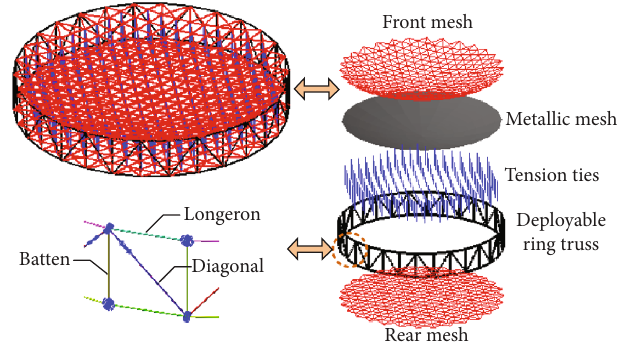
Figure 3: Components of AstroMesh re fl ector truss.